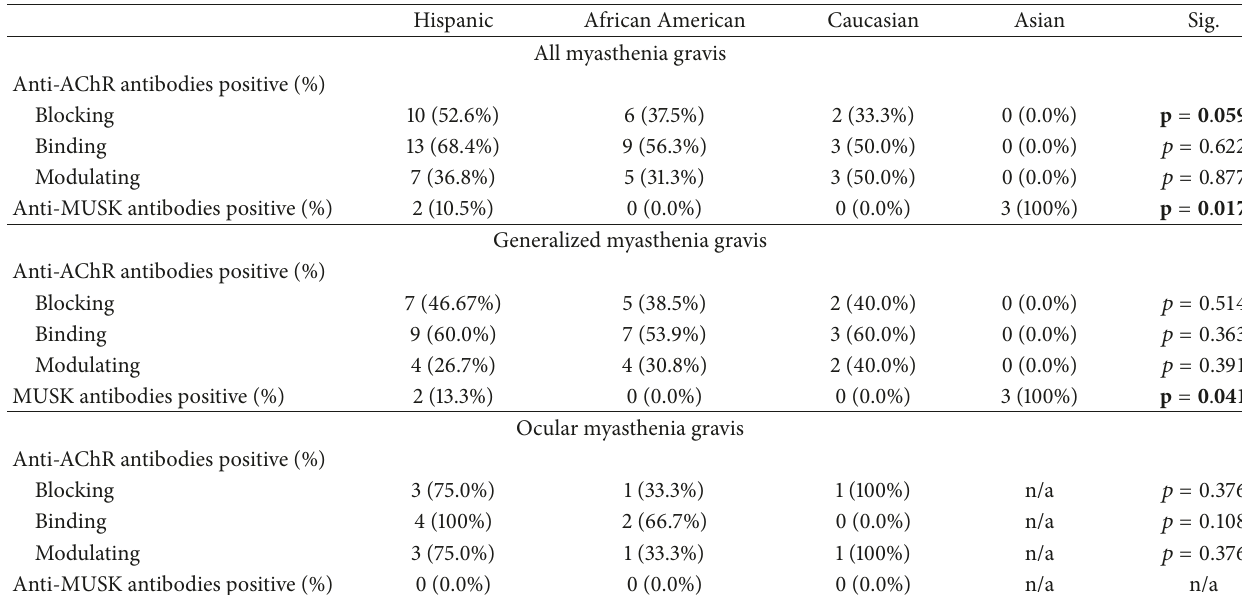
Table 2: Ethnicity and laboratory features in myasthenia